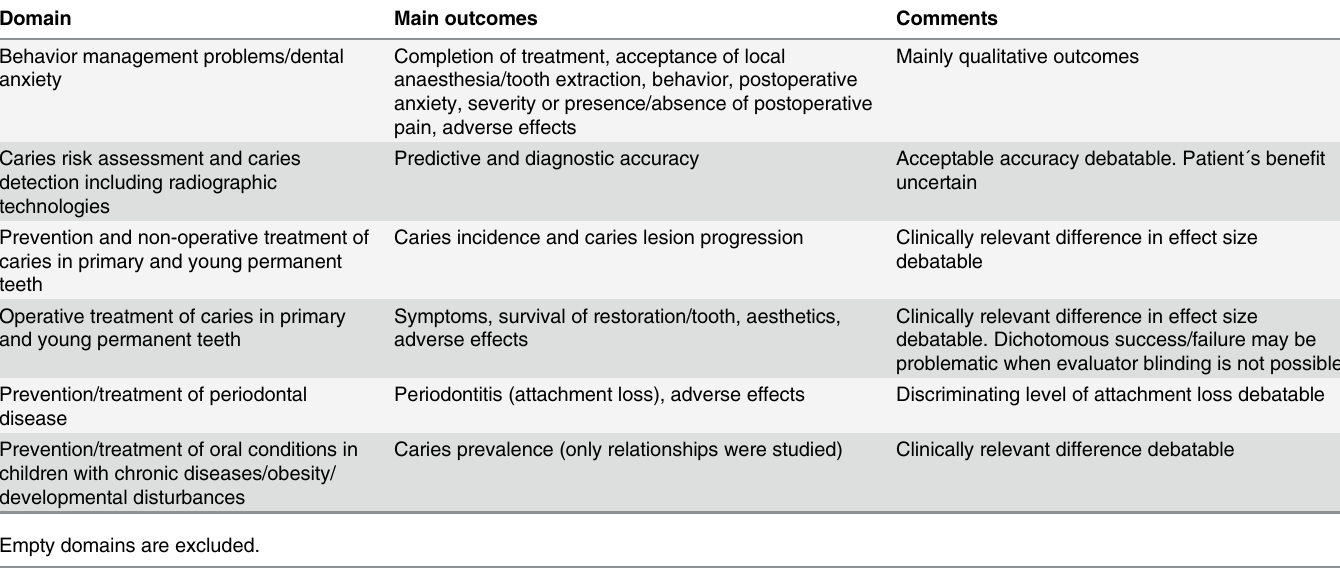
Table 5. Main outcomes used to evaluate the effects of an intervention/diagnosis/risk assessment related to domain of systematic reviews with low or moderate risk of